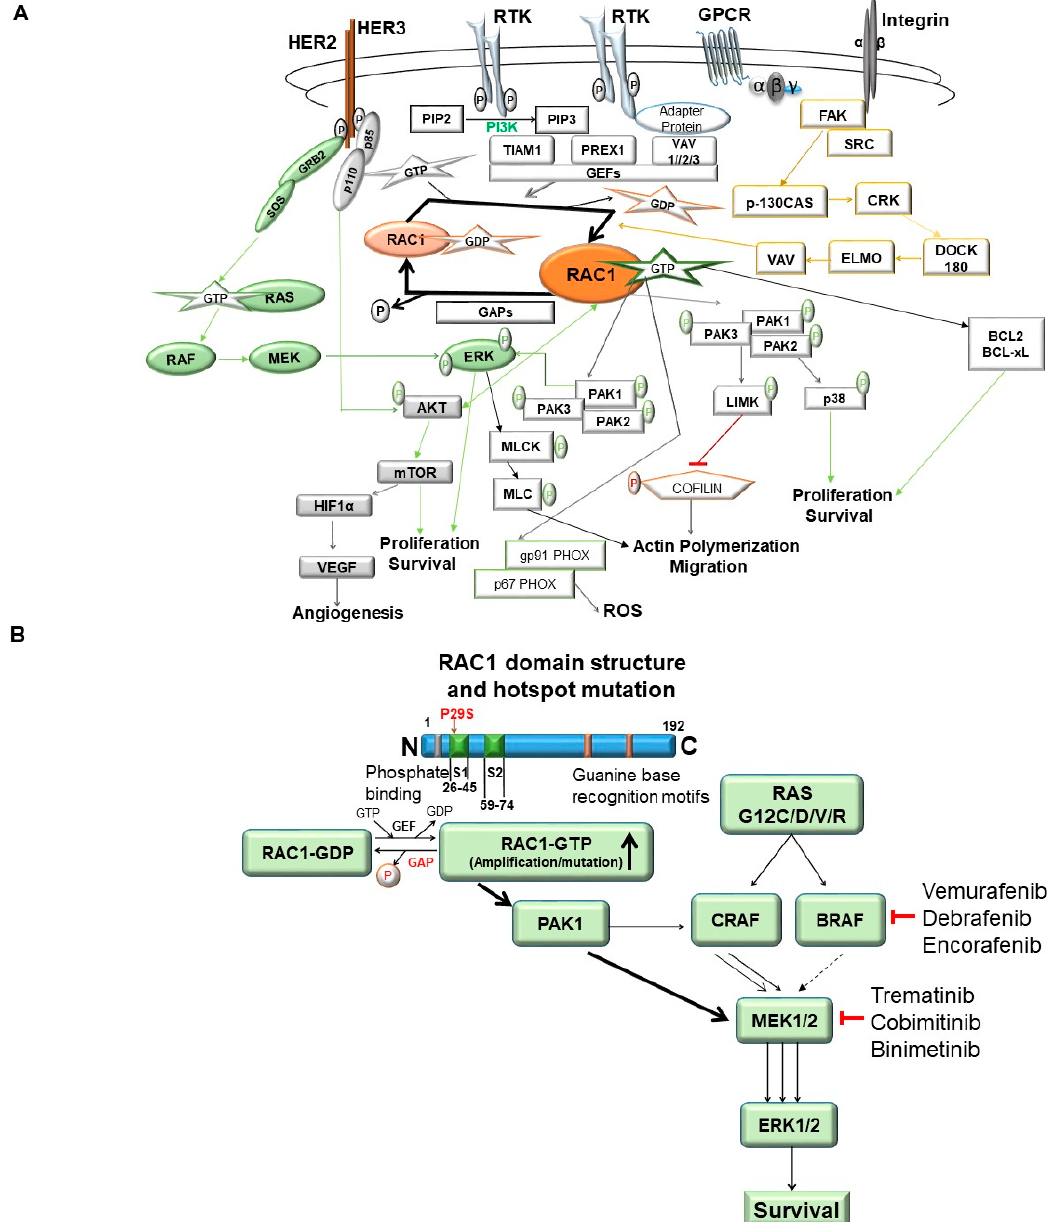
Figure 5. RAC1 signaling in tumor cells: RAC1 signaling in tumors cells and the involvement of the RAC1 protein in tumorigenesis and drug-resistance as presented in the review. ( A ) represents the RAC1 signaling pathway. RAC1 cycles between an inactive-GDP-bound form, and an active-GTP-bound form. Signals from cell surface receptors, for example, G-protein coupled receptors (GPCRs), receptor tyrosine kinases (RTKs), and integrins (alpha, beta) converge on the guanine nucleotide exchange factors (GEFS: VAV, TIAM, PREX), which converts RAC1 into its active state. Once activated, RAC1 can bind to a wide range of e ff ectors, which in turn influence both a variety of oncogenic phenotypes like proliferation / survival, actin remodeling / migration, metastasis, and angiogenesis in tumor cells. In the process of functions mentioned above within tumor cells, RAC1 signals are closely knit to both the PI3K-AKT and the RAS-MAPK pathways integrating extracellular stimulations with oncogenic alterations. Other mechanisms, such as the stabilization of the active form of RAC1 by sumoylation or sequestration of the inactive form by guanine nucleotide dissociation factors (GDIs), can also influence the level of RAC1 signaling. Schematic illustration of RAC1 signaling pathways and functions of its effectors are presented. Green font represents signaling events following phosphorylation-mediated activation of the protein. The red font represents signaling